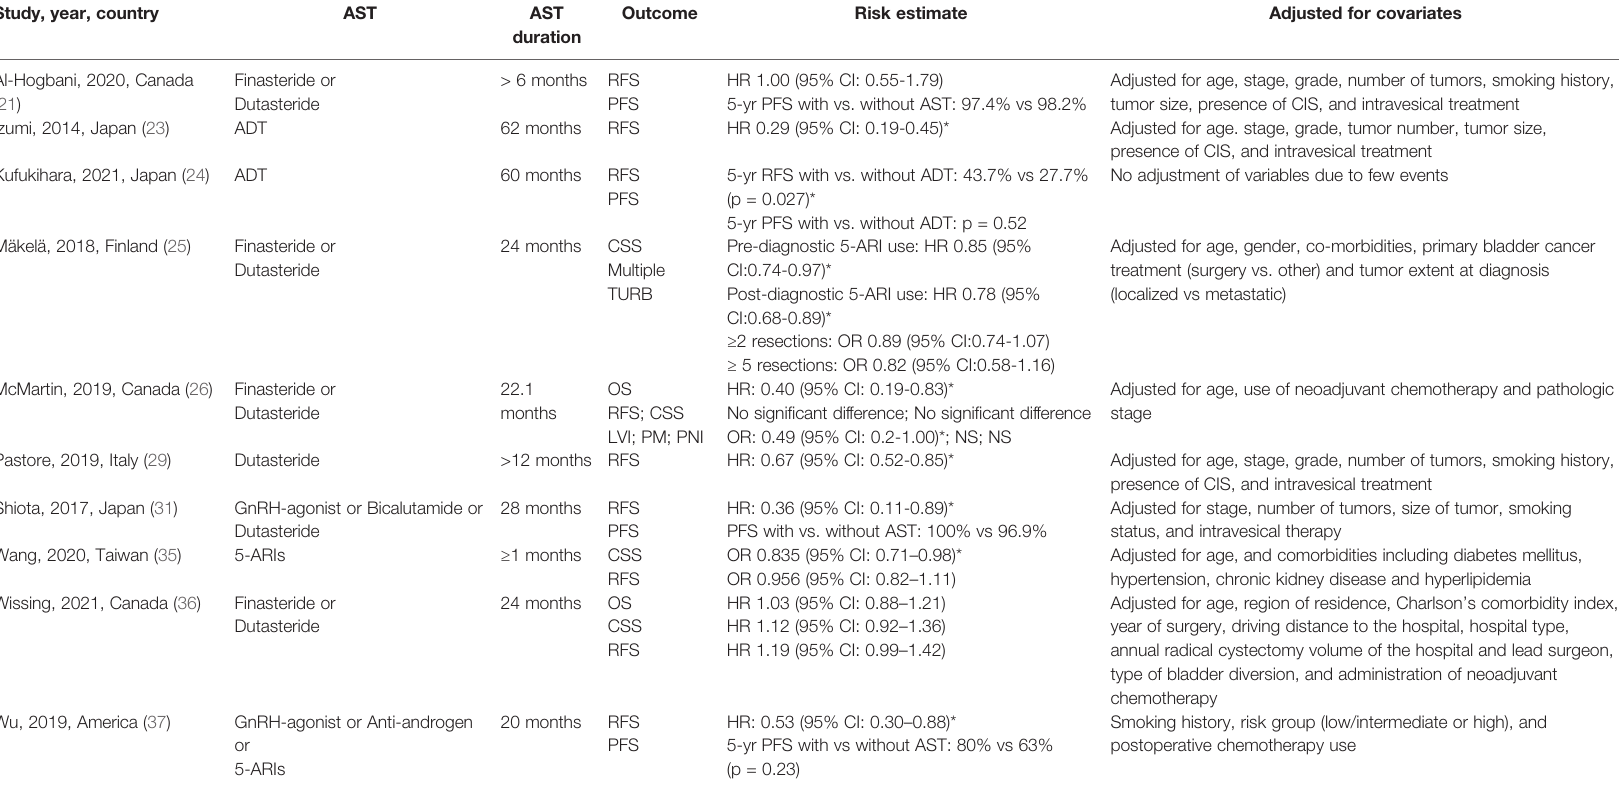
TABLE 3 | The effect of androgen suppression therapy on bladder cancer recurrence and